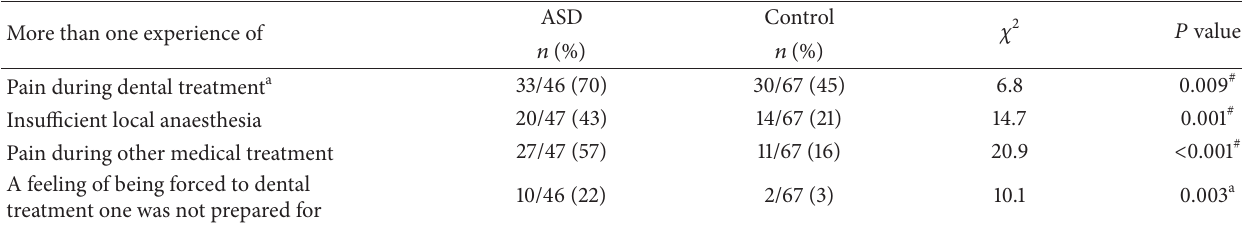
Table 3: Dental experiences in autism spectrum disorder (ASD) and controls.